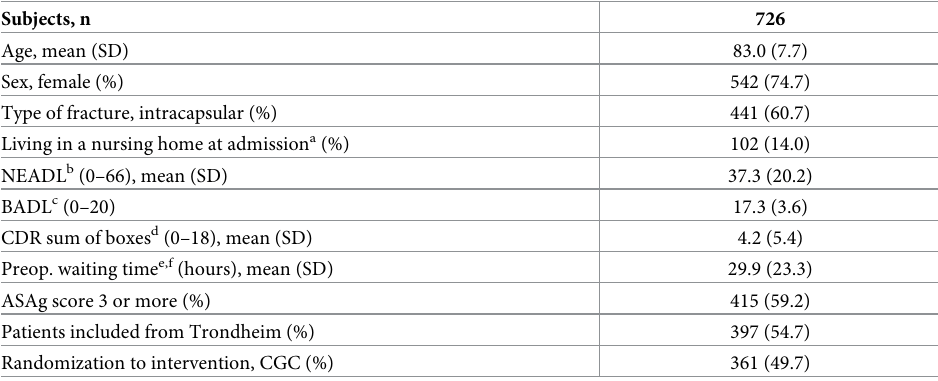
Table 1. Baseline